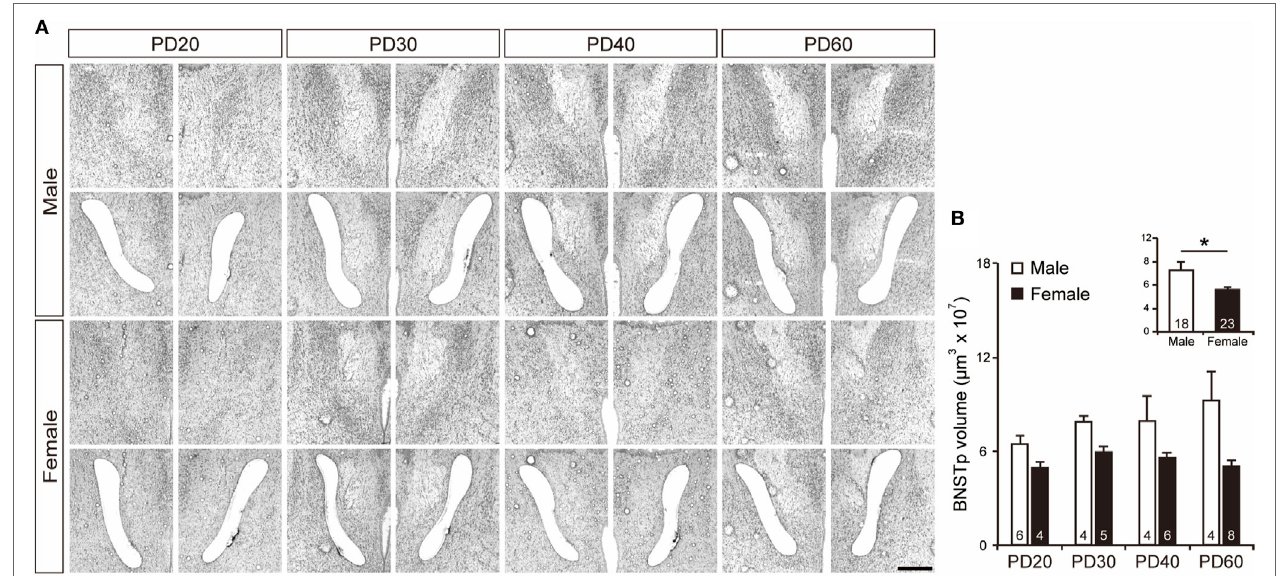
FigUre 2 | Isolation of the BNSTp. (a) Representative photographs showing brain sections before and after the BNSTp was isolated in male and female mice on PD20–60. Scale bar indicates 400 µm. (B) The volume of BNSTp tissues isolated from the brain of male and female mice on PD20, PD30, PD40, and PD60. The inset graph in panel (B) indicates the average volume of the BNSTp in all ages. The numbers in the columns indicate the numbers of animals. Values are the mean ± SEM. * p < 0.05.